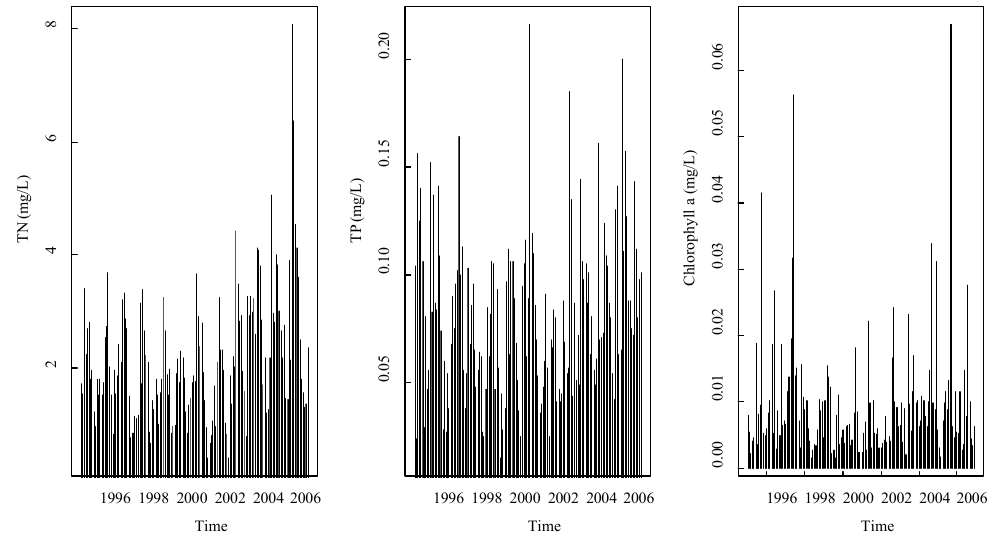
Figure 2. Time series of total nitrogen (TN), total phosphorus (TP), and chlorophyll a.